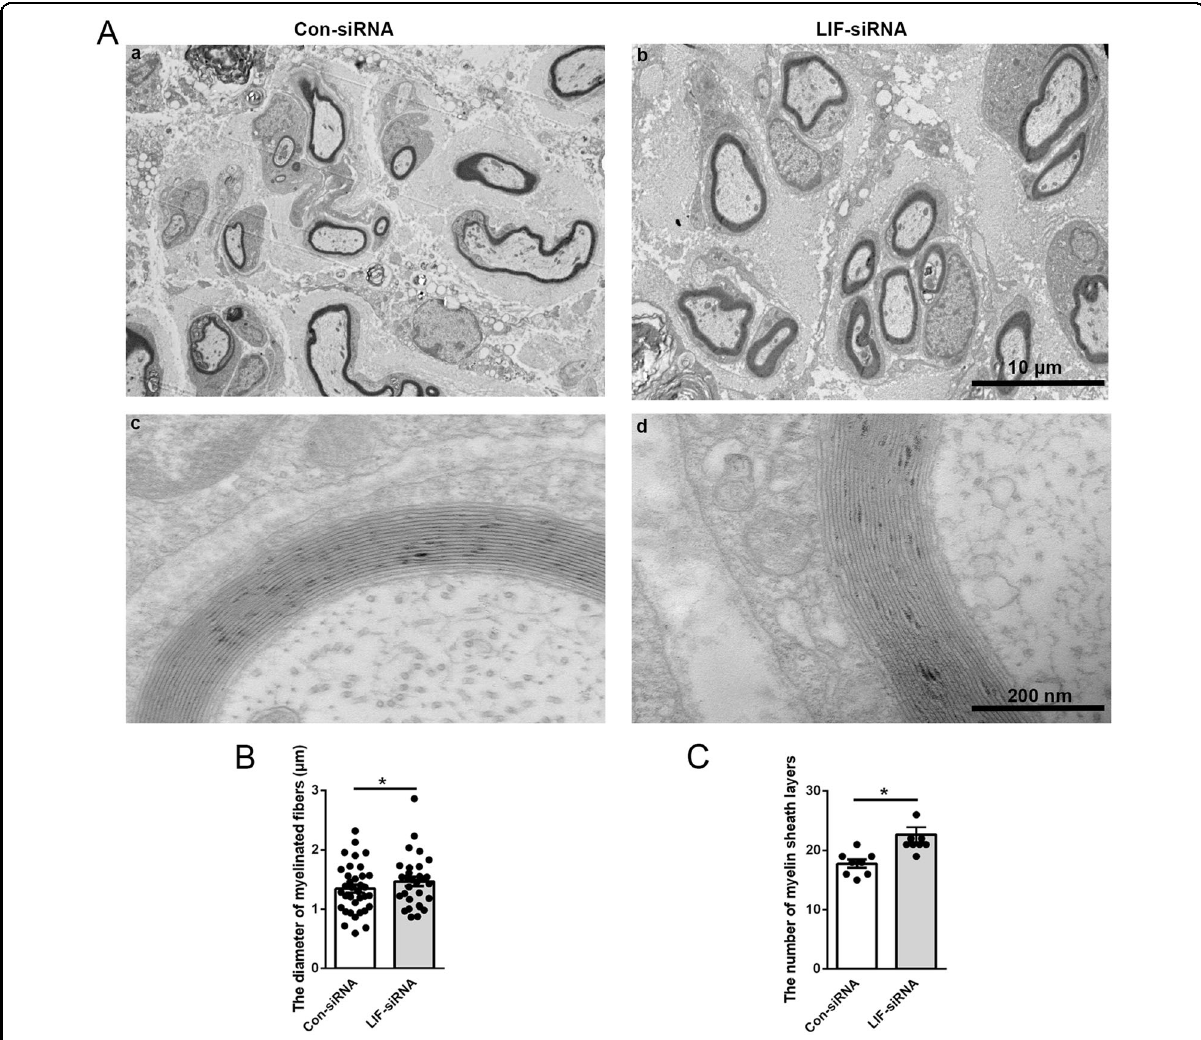
Fig. 5 LIF-siRNA promotes myelin sheath formation. A Representative transmission electron microscopy images of myelinated nerve fi bers of rats injected with control-siRNA or LIF-siRNA at 2 weeks after nerve crush injury. Scale bars indicate 10 μ m in upper images (a and b) and 200 nm in lower images (c and d). B , C Quanti fi cation of B the diameter of myelinated nerve fi bers and C the number of myelin sheath layers in rats injected with control-siRNA or LIF-siRNA at 2 weeks after nerve crush injury. Data were presented as means ± SEM. * p value <0.05 versus control-siRNA